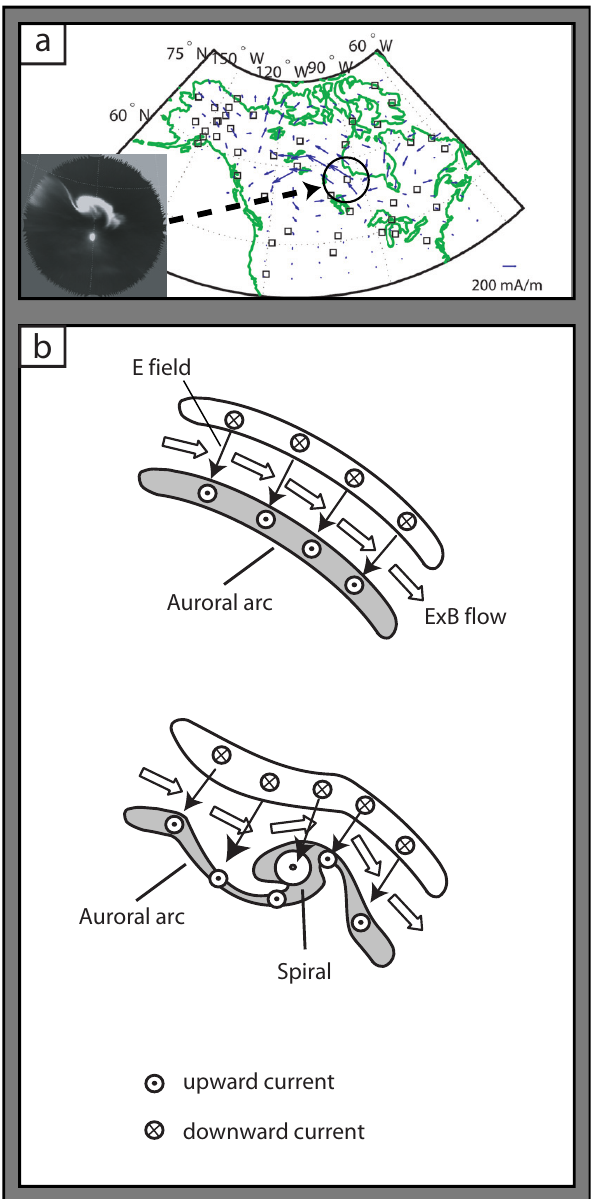
Fig. 8. Relationship among EICs, E × B flows, upward and down- ward currents, and auroral spirals. (Top) The auroral spiral (see inset) is collocated with intense EICs, which also correspond to enhanced E × B flows in the ionosphere. (Bottom) Schematic of several physical quantities in the ionosphere before and at auroral spiral